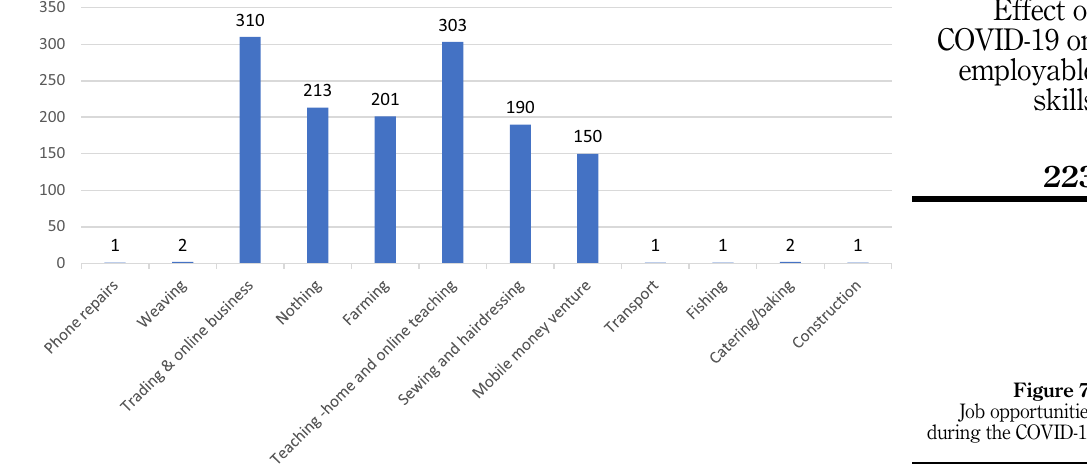
Figure 7. Job opportunities during the